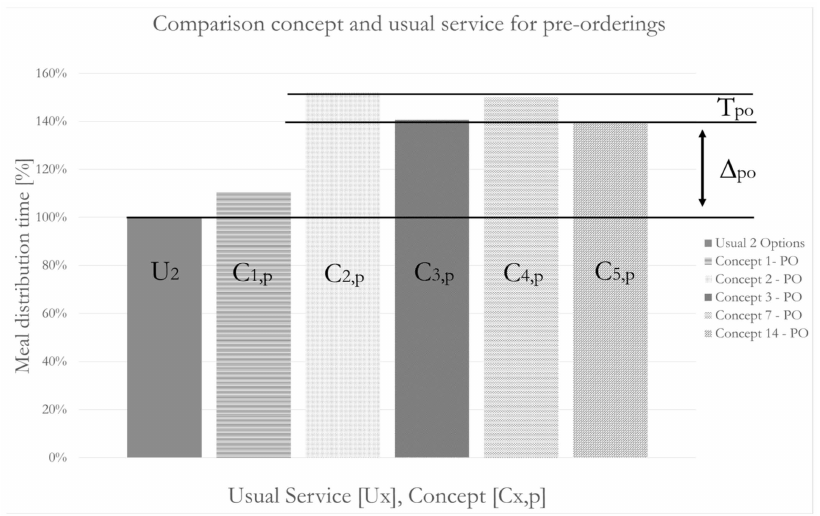
Figure 27. Comparison of meal distribution service time with an increased number of pre-orders, shown in